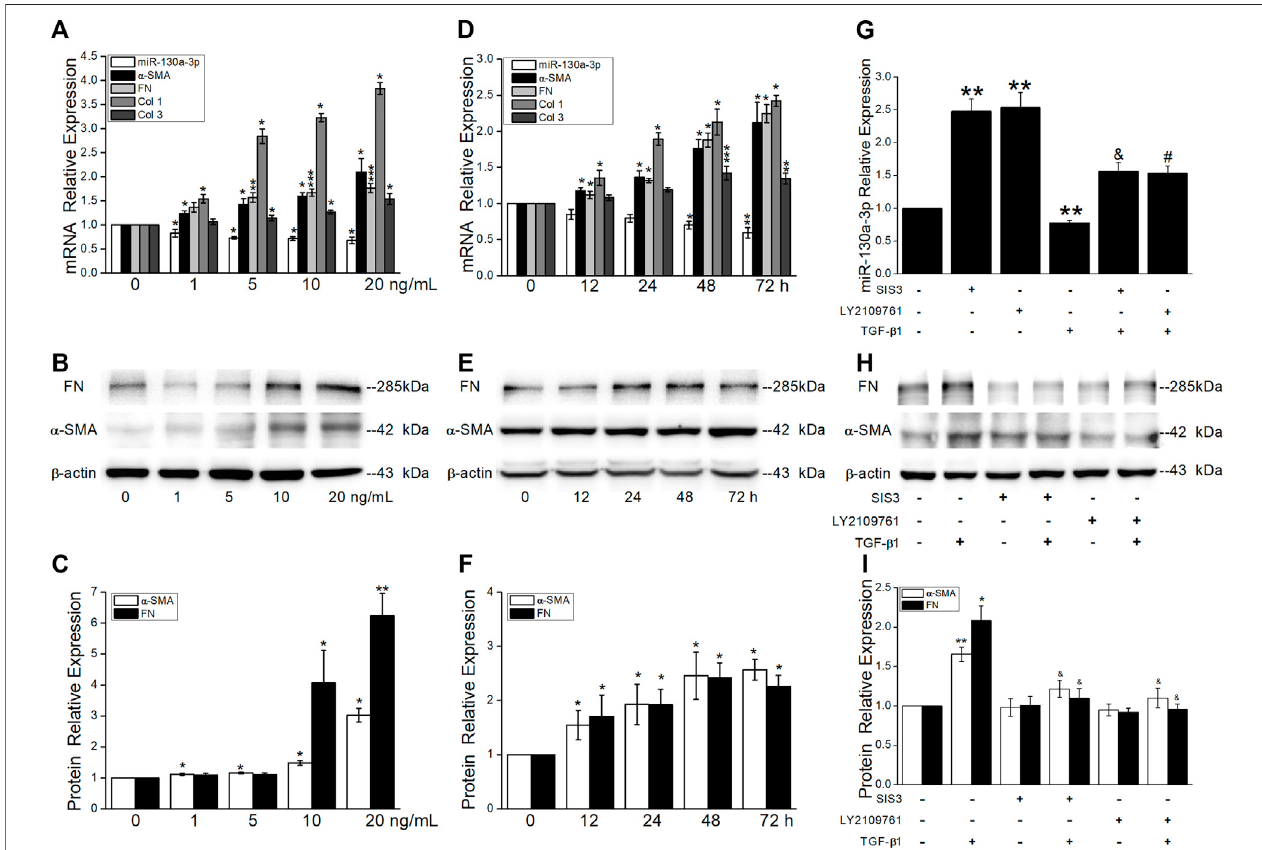
FIGURE8| TGF- β 1reducesmiR-130a-3pexpressionviaSmad3signalingpathways.MRC-5cellswerestimulatedwithvariousconcentrationsofTGF- β 1for48 h or with 5 ng/ml of TGF- β 1 for different periods of time. (A,D) qRT-PCR quantitation of mRNA expressions of miR-130a-3p and fi brosis-related genes. (B-C,E-F) Representative and statistical data of α -SMA and FN proteins. * p < 0.05, ** p < 0.01, *** p < 0.001, versus 0 ng/ml or 0 h, by the Mann – Whitney U test, n = 3 – 5. MRC-5 cells were pretreated with 10 μ M of TGF- β RII inhibitor (LY2109761), Smad3 inhibitor (SIS3), or control (DMSO) for 30 min and then stimulated with 10 ng/ml of TGF- β 1 for 24 h. (G) qRT-PCR quantitation of mRNA expression of miR-130a-3p. ** p < 0.01, versus the control group; & p < 0.05, versus the SISI3 group; # p < 0.05, versustheLY2109761group,bytheMann – Whitney U test, n =4 – 6. (H – I) Representativeandstatisticaldataof α -SMAandFNproteins.* p < 0.05,** p < 0.01,versusthe control group; & p < 0.05, versus the TGF- β 1 group, by the Mann – Whitney U test, n = 4-5.